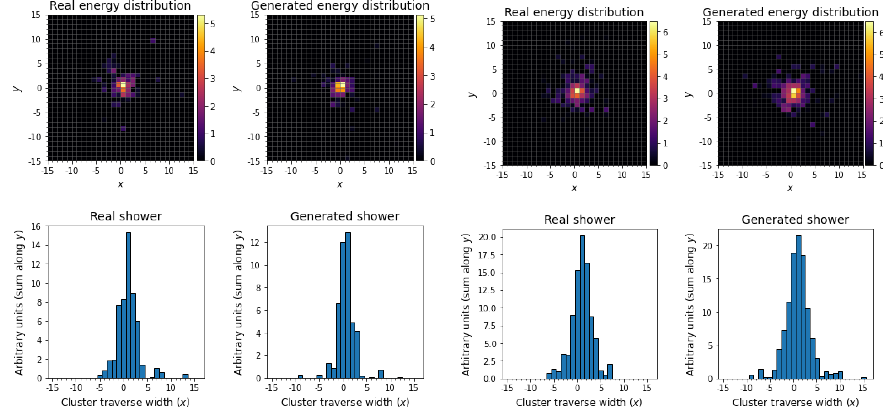
Figure 4: SAGAN trained on log energies generated samples